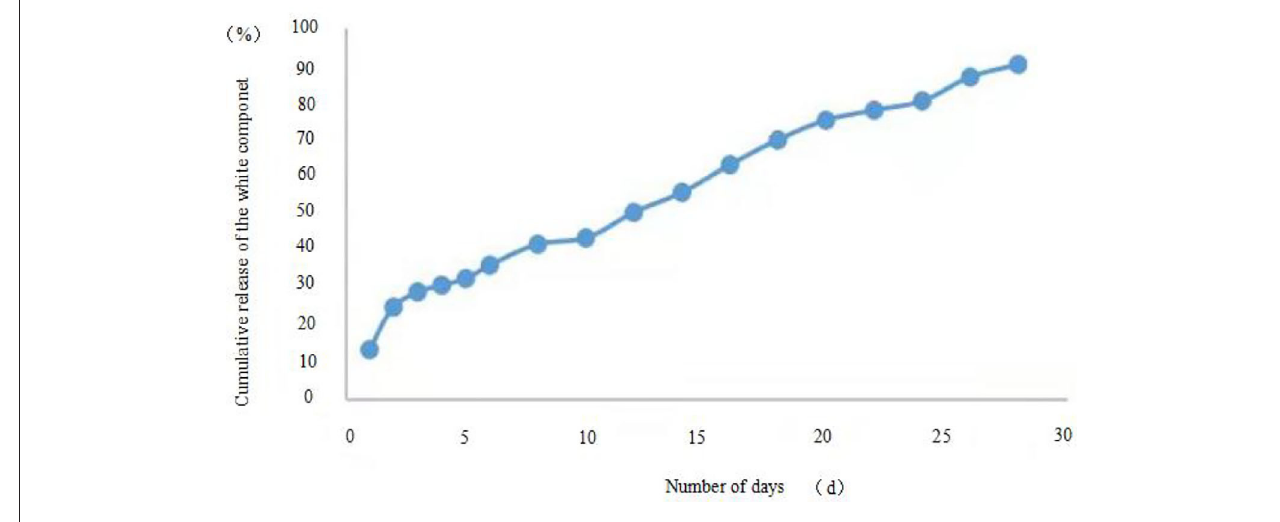
FIGURE 5 | Microcapsule 1 release curve.